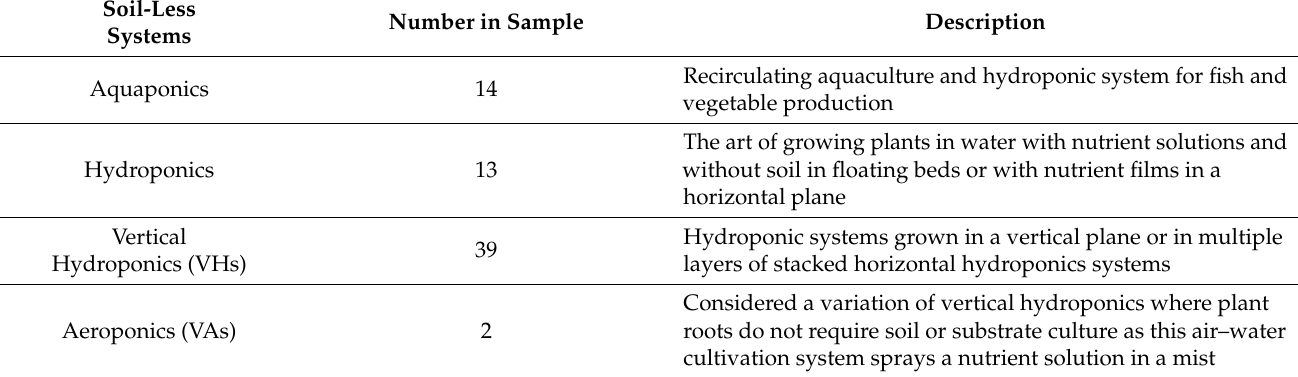
Table 2. This is a table of the description and application of soil-less growing systems in the literature. The study sample included four different types of growing systems: Aquaponics, Hydroponics, Vertical Aeroponics (VAs) and Vertical